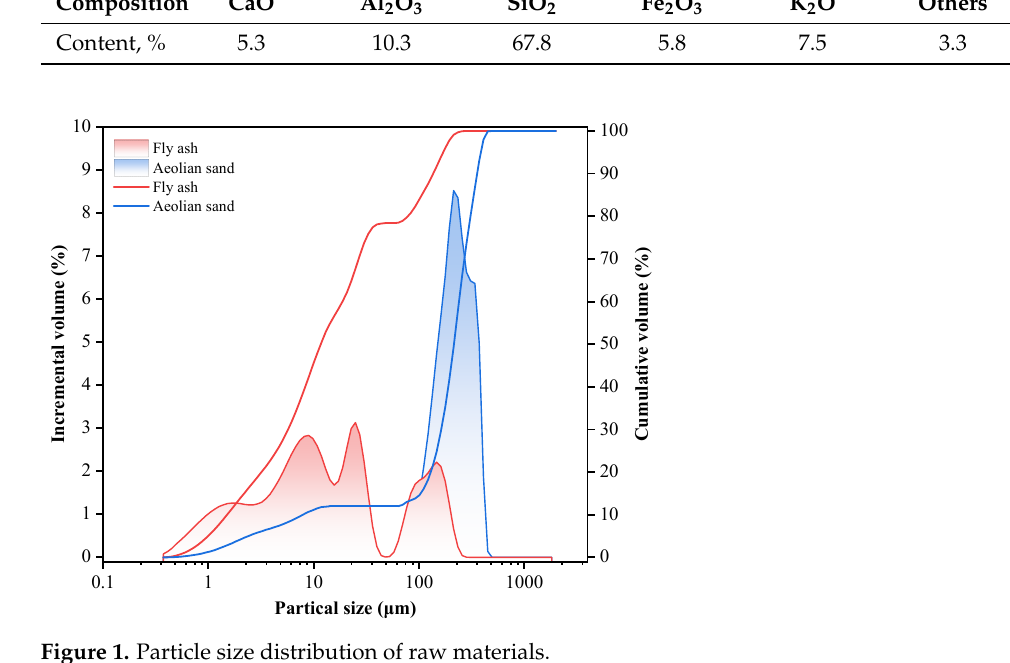
Figure 1. Particle size distribution of raw materials.